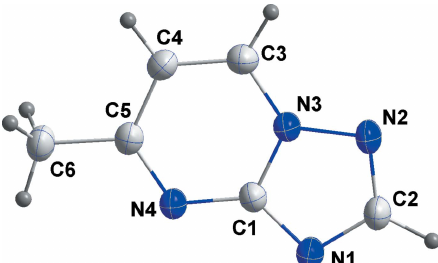
Figure 1 The title molecule with the atom-labelling scheme and 50% probability ellipsoids.